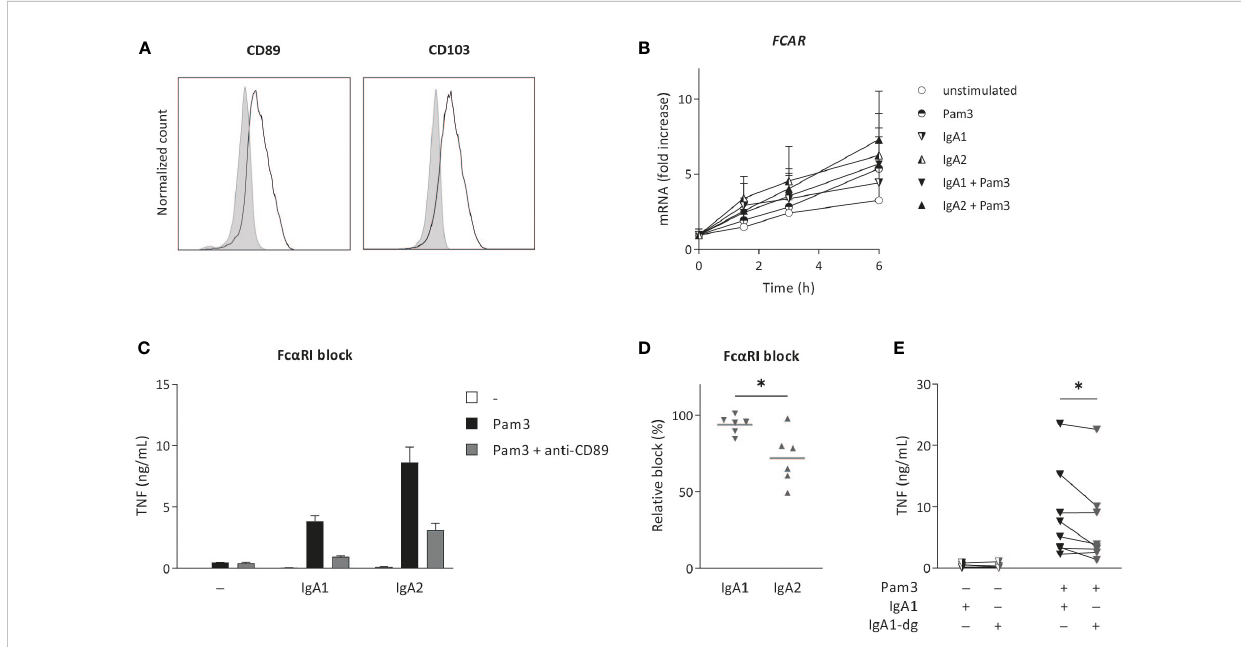
FIGURE 3 IgA2-induced cytokine production is only partially dependent on Fc a RI. Surface expression of FC a RI (CD89) and CD103 was analyzed on in vitro differentiated CD103 + DCs (A) . Expression was compared to unstained cells (grey). Data shown of a representative example of four donors. FCAR mRNA expression after (co-) stimulation with Pam3CSK4 (Pam3) and IgA1 or IgA2 was measured at indicated time points and normalized to the mean expression of RACK1 , HPRT1 , and UBB (data of four donors shown as mean + SD) (B) . Pro-in fl ammatory cytokine production upon (co-) stimulation (40,000 cells/well) after pre-treatment with anti-CD89 antibodies (Fc a RI block) was analyzed (representative example, measured in triplicate) (C) . The effect of anti-CD89 pre-treatment on TNF production was compared to co-stimulation of non-treated CD103 + DCs (D) . Data of six independent experiments. Effects of N-glycosylation on cytokine production was tested for multiple donors using de-glycosylated IgA1 (IgA1-dg) in stimulation experiments with Pam3 (E) . *p <